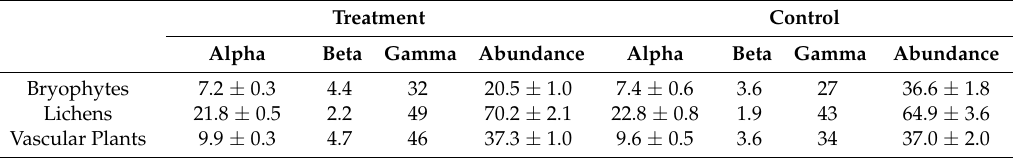
Table 2. Species diversity measures (means ± S.E.M.) for the treatments (n = 70) and control plots (n = 27) for three species groups. Data are from the five subplots within each of the 97 plots (see methods for